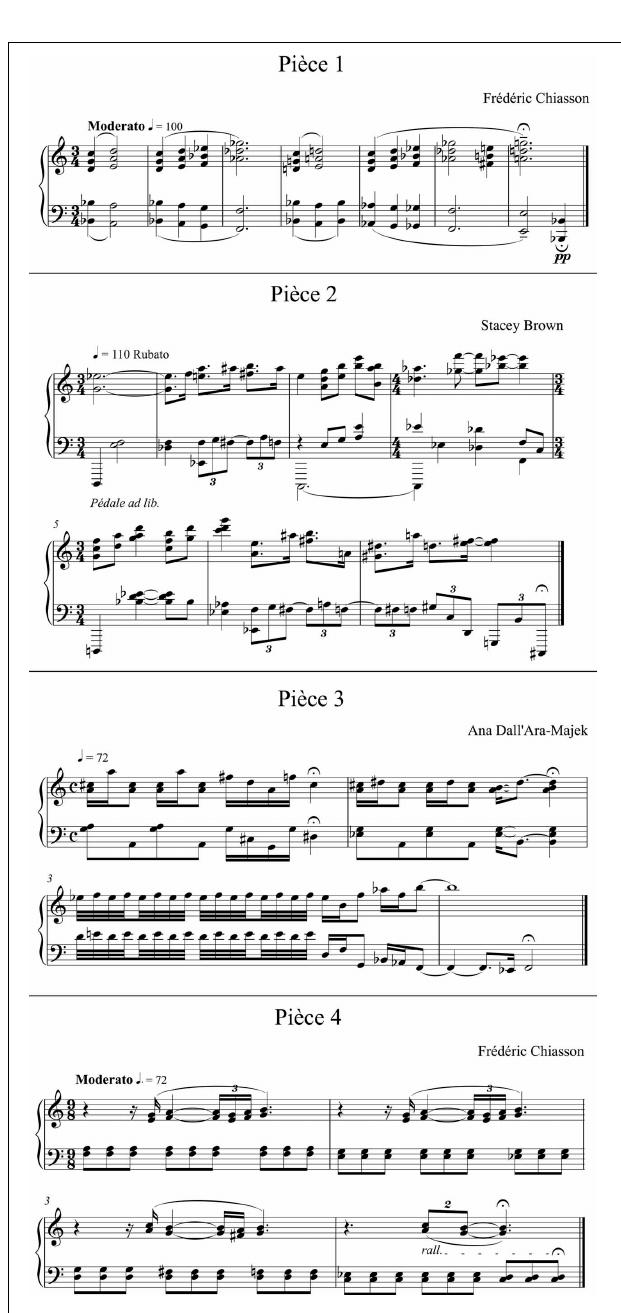
FIGURE 1 | Scores of the four pieces composed and selected for the